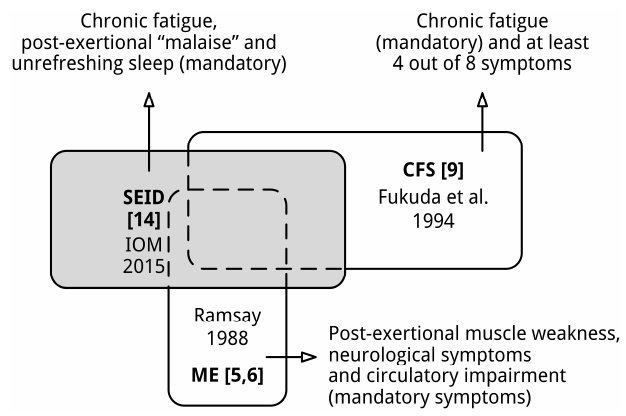
Figure 2. SEID is neither covering ME nor CFS. The sizes of the shapes do not reflect the absolute sizes of various patient